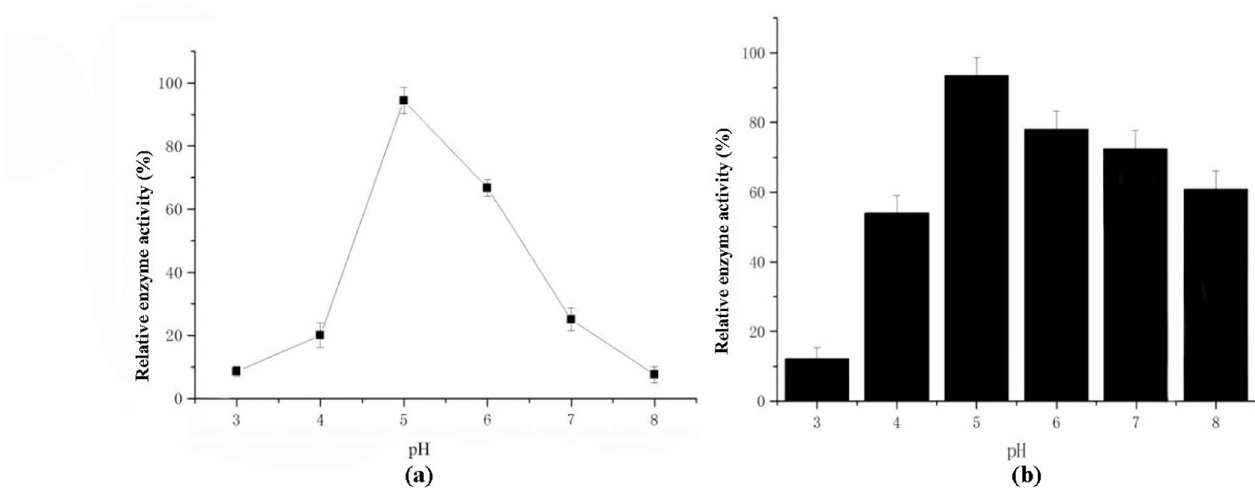
Fig 4. The optimum reaction pH of AglB (a) and its stability at different pH (b).